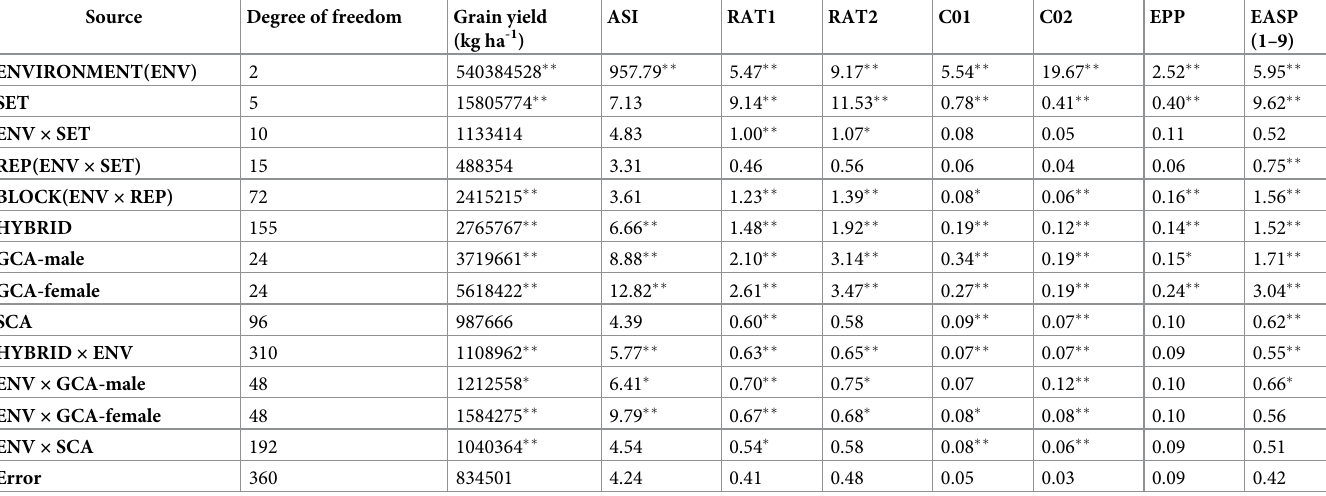
ASI = Anthesis-silking interval, RAT1 and RAT 2 = Striga damage rating at 8 and 10 WAP, C01 and C02 = Emerged Striga plants at 8 and 10 WAP, EPP = number of ears per plant, EASP = Ear aspect, GCA-male = general combining ability effects of male, GCA-female = general combining ability effects of female, SCA = specific combining ability effect � , �� = Significant at 0.05 and 0.01 probability levels,